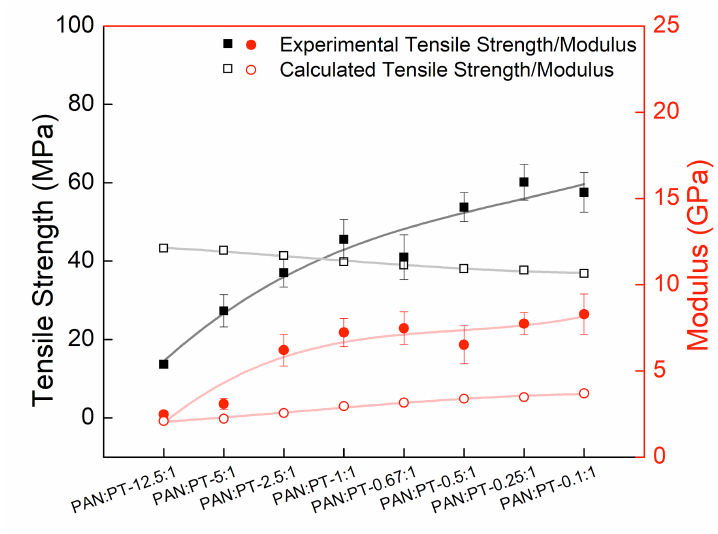
Figure 10. Tensile property comparison of experimental measured and theoretical calculated values based on